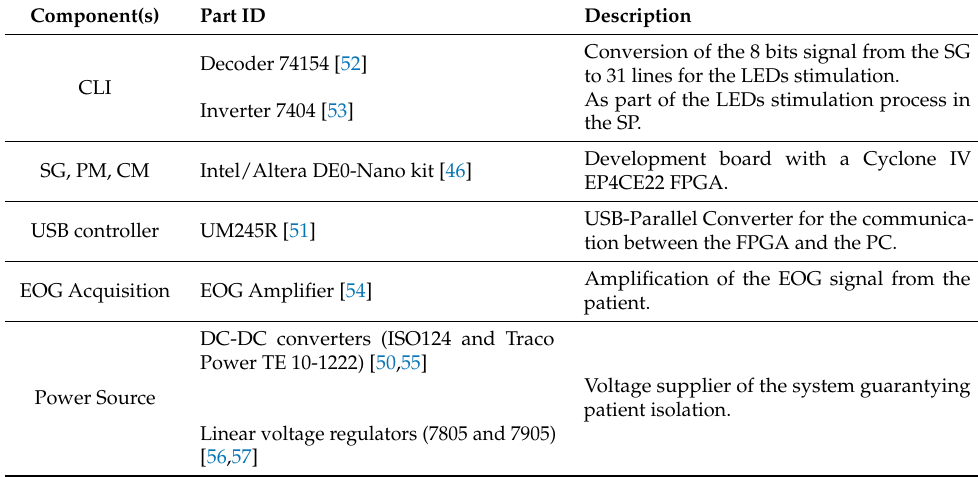
Table 3. Components used for implementing the